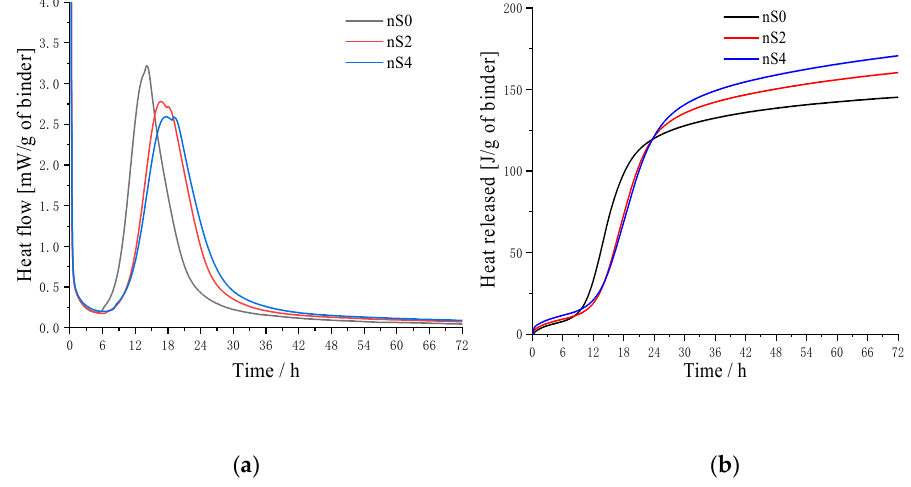
Figure 2. Isothermal calorimetry curves of all UHSCs for 72 h. Heat flow curves ( a ) and cumulative heat curves ( b ).